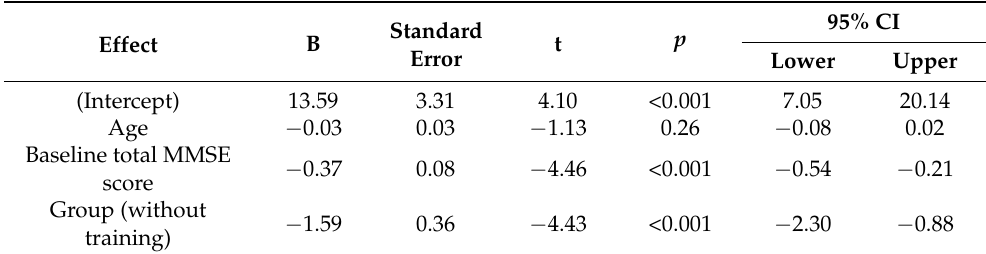
Table 5. Regression estimates of initial model of prediction of changes MMSE total score based on group factor and MMSE background total score and age.